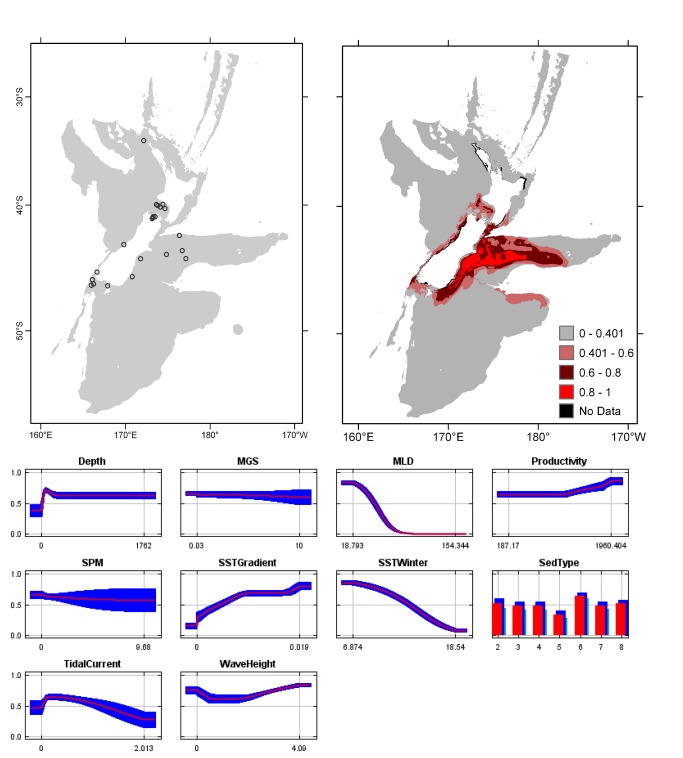

Celleporinagrandis

 known distribution (left), predicted suitable habitat (right), and fitted responses curves (marginal).For the predicted distribution, logistic probabilities less than the 10th percentile presence value indicated cells were unsuitable habitat. Probabilities of 0.4–0.6 indicated habitat suitability typical of the presence records, values of 0.6–0.8 and 0.8–1 indicated favourable and highly suitable habitat, respectively. Black cells had missing data in one or more environmental layer. Independent records are layed over the predictions. Marginal response curves show how the prediction changes for different values of each variable when all other variables were at their average sample value. Individual response curves are shown in Figure S3. For the categorical variable Sediment type: 1 = deep ocean clays; 2 = calcareous gravel; 3 = volcanic; 4 = calcareous mud; 5 = gravel; 6 = mud; 7 = sand; 8 = calcareous sand.